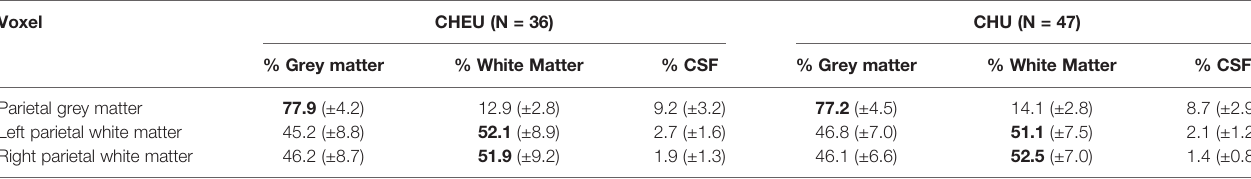
TABLE 2 | Fractional tissue composition in each de fi ned MRS voxel, according to HIV exposure.